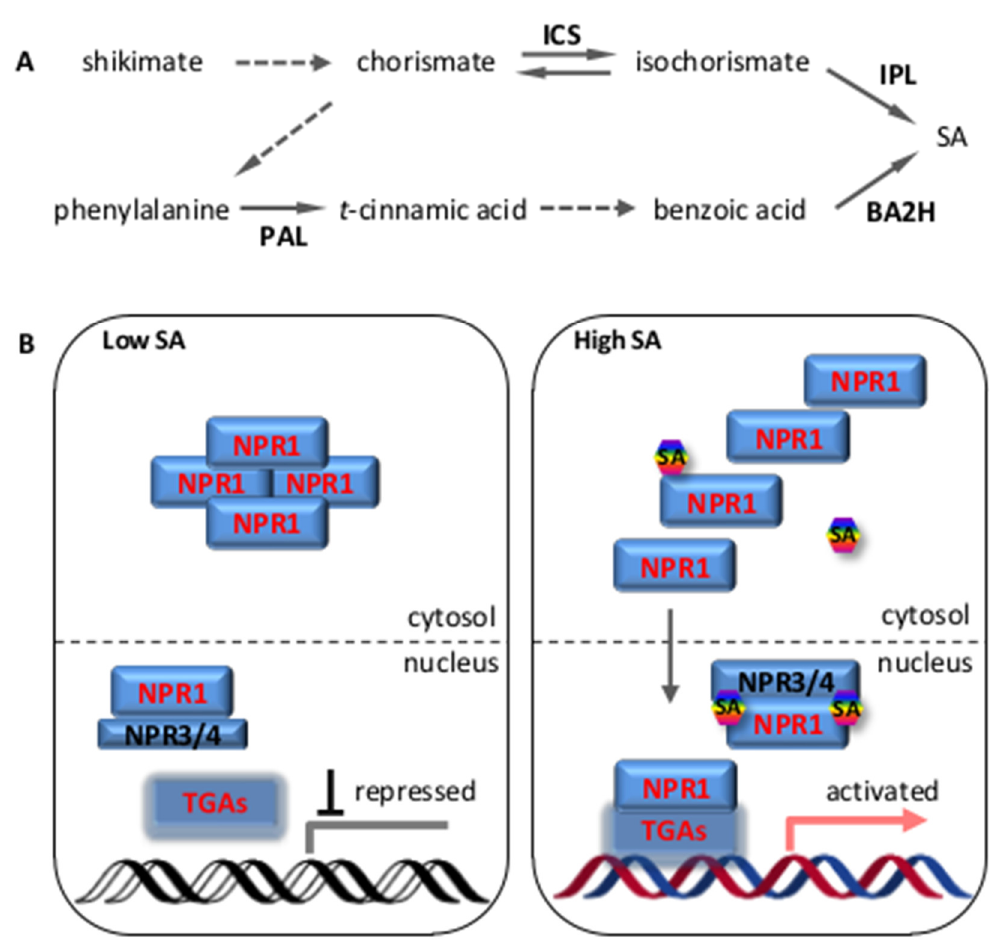
Figure 1. Salicylic acid biosynthesis and signaling pathway. ( A ) Proposed model for salicylic acid (SA) biosynthesis in Arabidopsis. Upper panel: the isochorismate pathway revealed by genetic studies. Lower panel: the phenylpropanoid pathway revealed by biochemical studies. ( B ) A simplified model for the SA signaling pathway according to Ding et al. [18] and Mou et al. [19]. In cells with low SA levels, NPR1 forms oligomer and remains in the cytosol, NPR3 and NPR4 bind residual NPR1 in the nucleus to prevent NPR1 function. In cell with high SA levels, NPR1 becomes monomeric and enters the nucleus, where SA binds to NPR3 and NPR4 to block their transcriptional repression activity. NPR1 interacts with TGAs in SA-responsive promoters, leading to the activation of defense responses. Abbreviations: BA2H, benzoic acid 2-hydroxylase; ICS, isochorismate synthase; IPL, isochorismate pyruvate lyase; NPR, non-expresser of pathogenesis-related genes; PAL, phenylalanine ammonia lyase; SA, salicylic acid; TGA, TGACG-binding